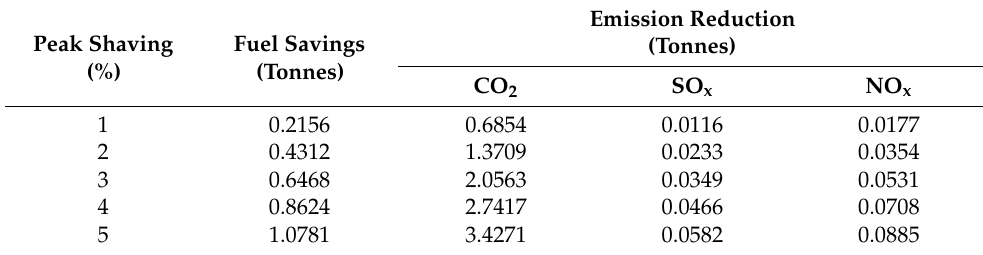
Table 11. Reductions from peak shaving for Route 1.